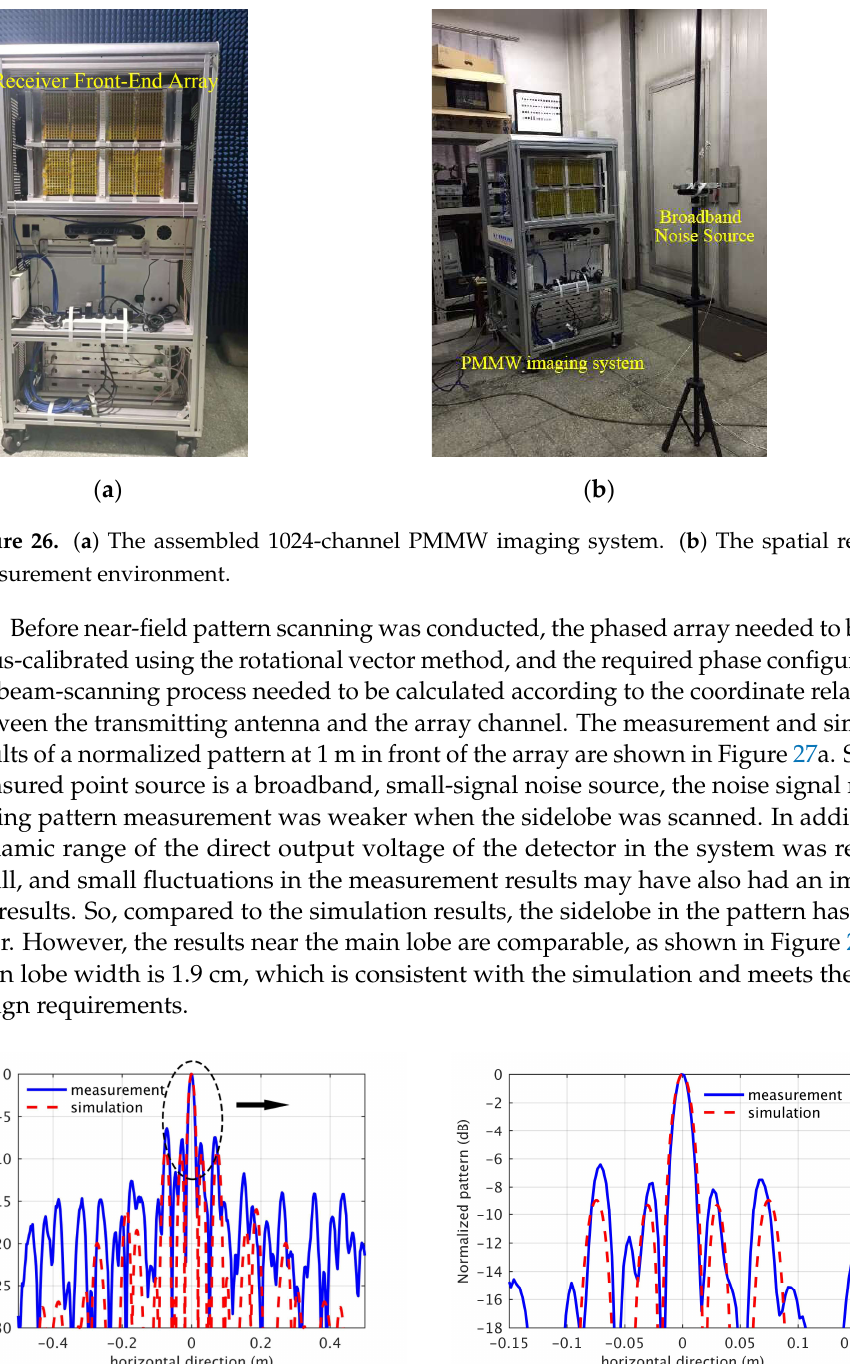
array. ( b ) The main lobe in the pa(cid:308)ern.